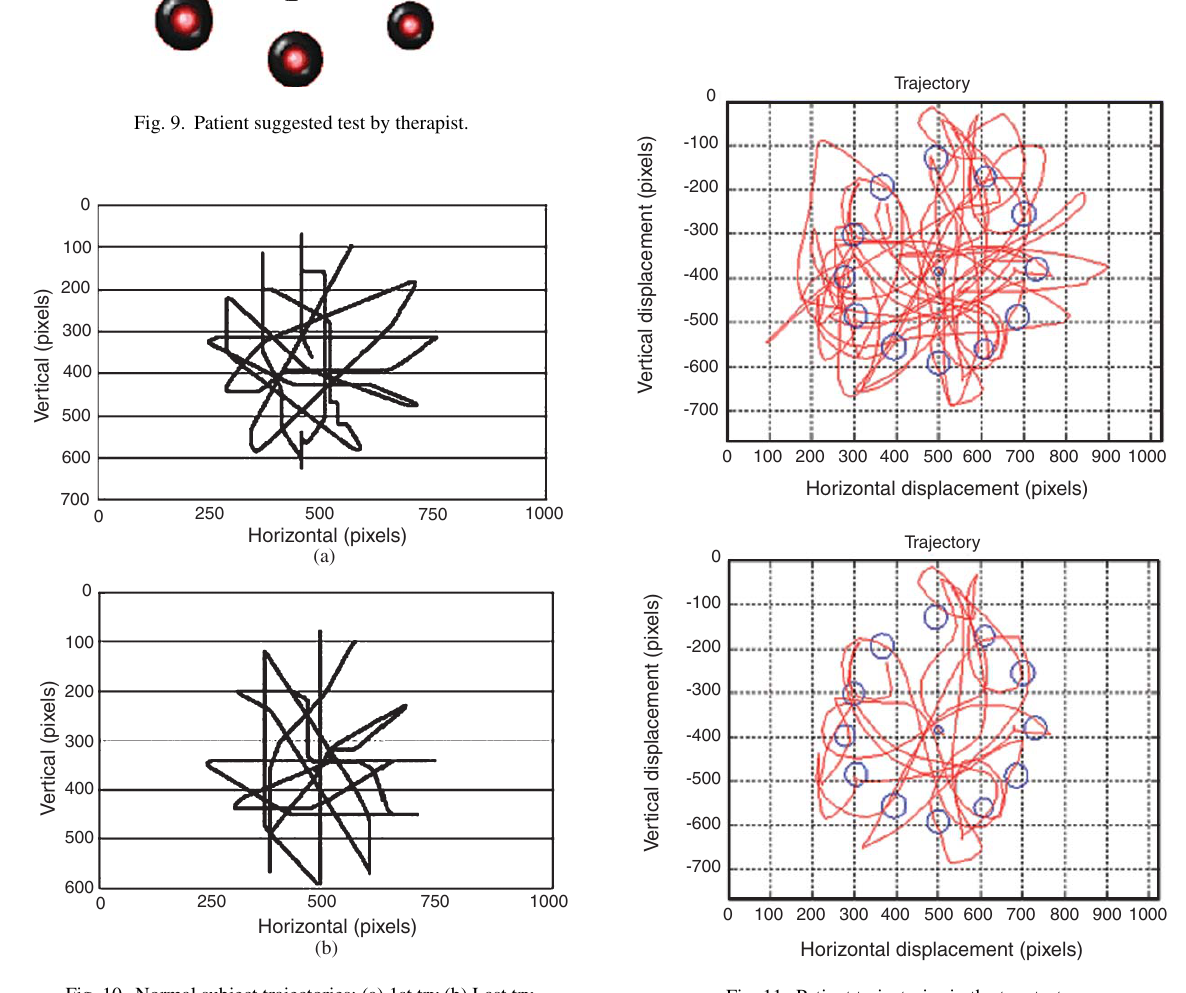
Fig. 10. Normal subject trajectories: (a) 1st try (b) Last try. Fig. 11. Patient trajectories in the two